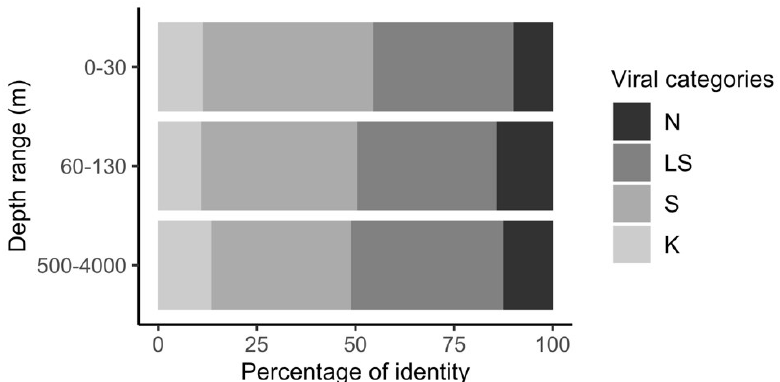
Figure 2. Depth distribution of novel and known bacteriophage contigs. Similarity to previously sequenced viromes and metagenomes was assigned with a BLASTn analysis against the IMG/VR database (2018) using a similarity cut-off of >60% genes with >70% nucleotide identity. Similarity categories: N (novel: shared < 20% genes), LS (low similarity: share > 20% and < 60% genes), S (similar: share > 60% and < 80% genes), K (known phage: share > 80% of the genes). Contig abundance was normalized based on read counts.